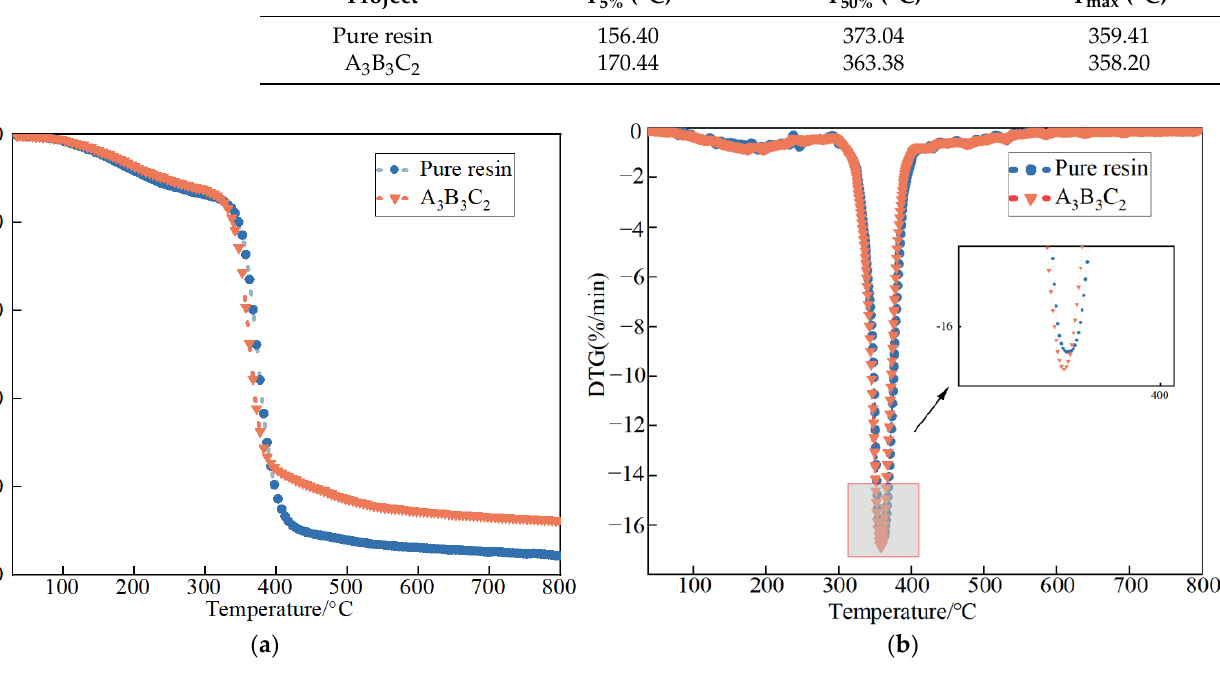
Figure 8. TG and DTG curves of different groups of PU-ER: ( a ) TG; ( b ) DTG. Table 10. TGA parameters before and after adding filler/ °C.